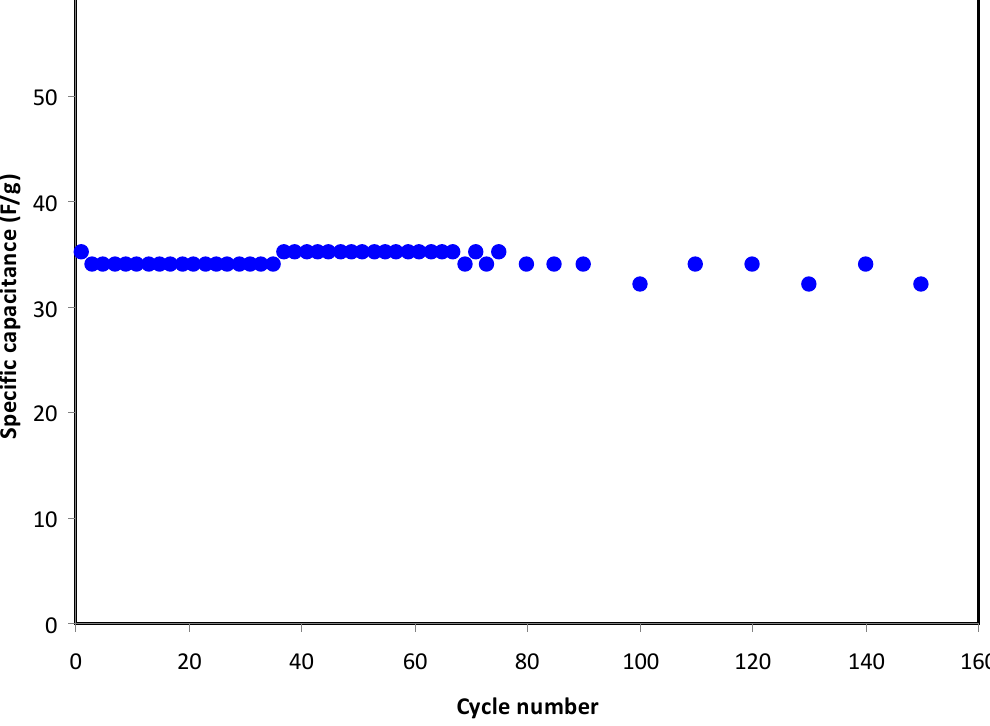
Figure 9. The specific capacitance, C s of the constructed EDLC versus cycle number.